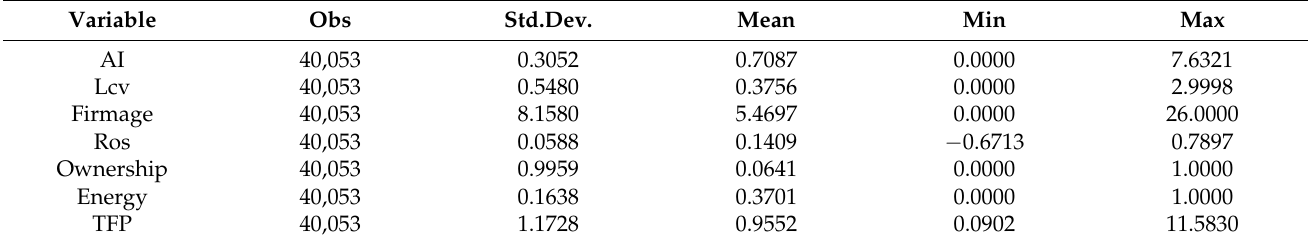
Table 2. Descriptive statistics of